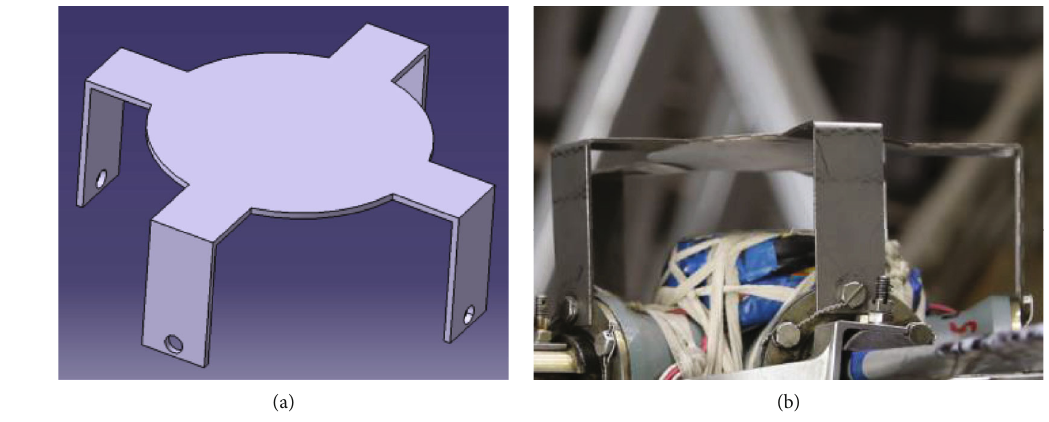
Figure 3: (a) Structure and (b) installation of the hub hat.